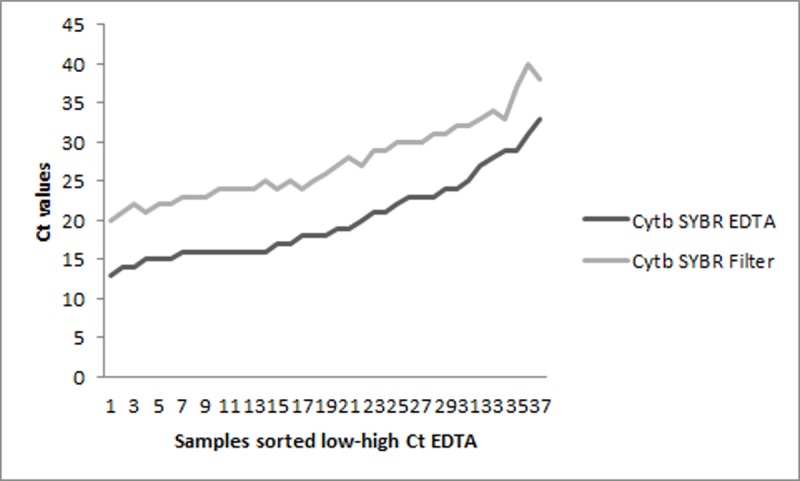
Ct value comparisons of DNA samples extracted from 200 μl EDTA whole blood versus filter paper 50 μl blood (N = 37).Positive P.falciparum material from 37 patients had been collected and extracted by two different methods resulting in DNA from whole blood purified by spin-column, and DNA from filter paper purified by Chelex-100 [5, 18]. The two Ct trends showed a constant difference of 4–9 cycles, and for 31 out of 37 samples the difference was 7–9 cycles.